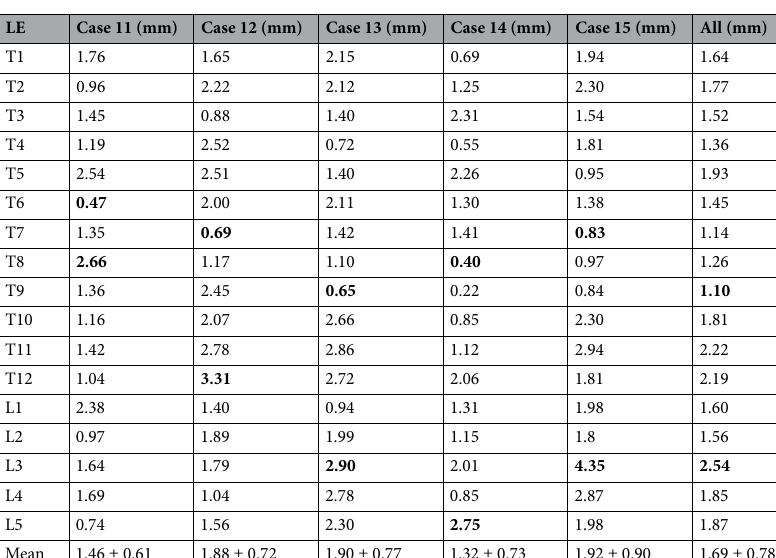
Table 3. The location errors of the predicted vertebrae centroids. Bold values indicates maximum and minimum values of the corresponding column or row.